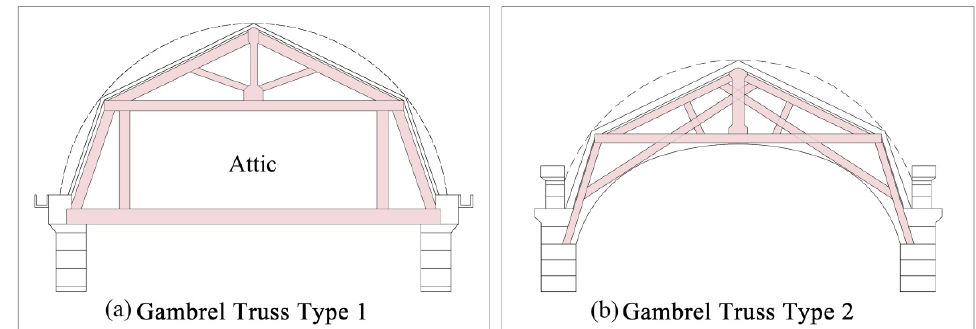
Figure 15. Two Typical Gambrel Truss Types.